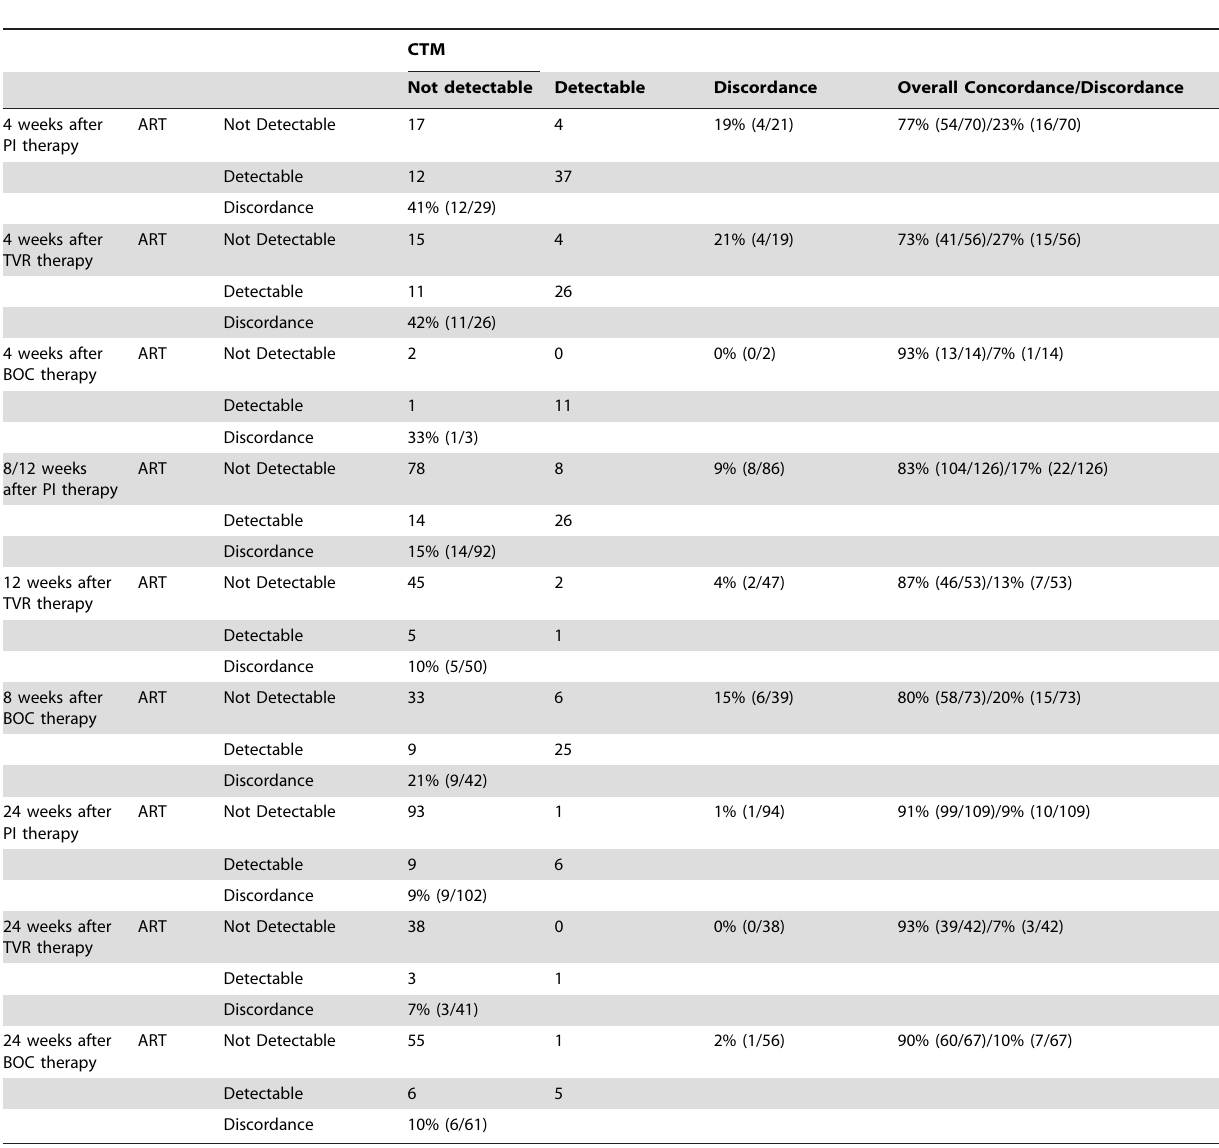
Table 1. Concordance and discordance between the ART and the CTM in classifying samples as HCV RNA undetectable or low viremic ( , 50 IU/ml) obtained 4, 8 (BOC), 12 (TVR) and 24 weeks after the start of PI-based